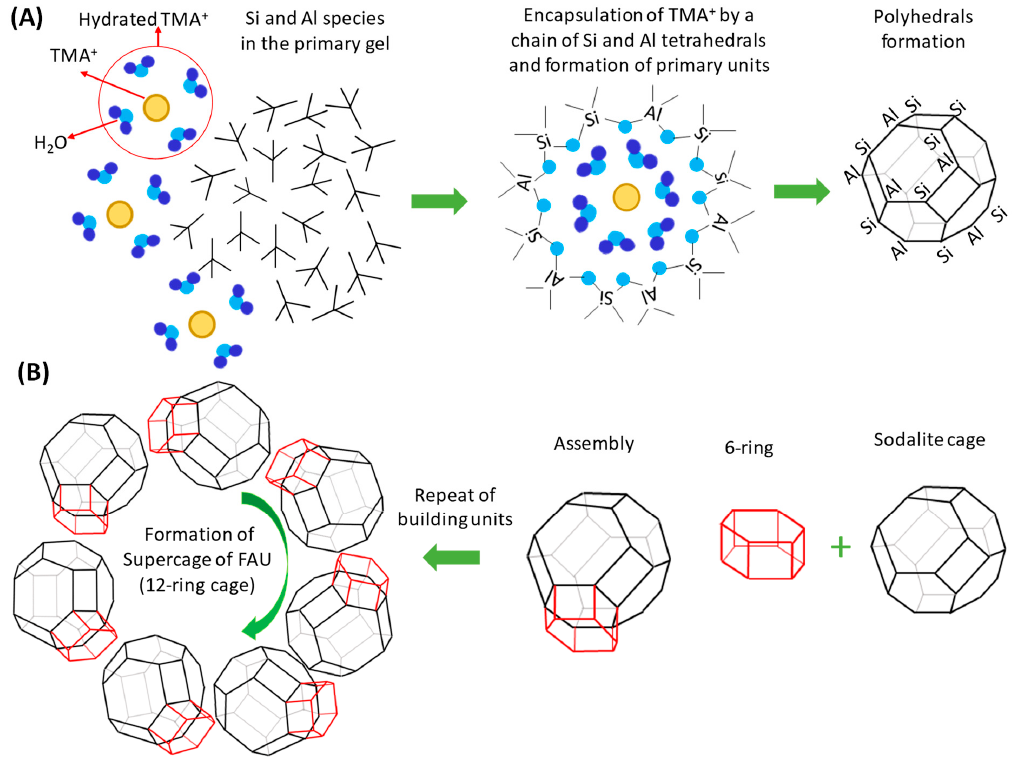
Figure 2. Schematic representation of ( A ) The formation of primary zeolitic Y building blocks (FAU topology) around organic SDAs (TMA + ) and ( B ) the formation of zeolite Y supercage by assembly of secondary building blocks (i.e., sodalite and 6-ring units).